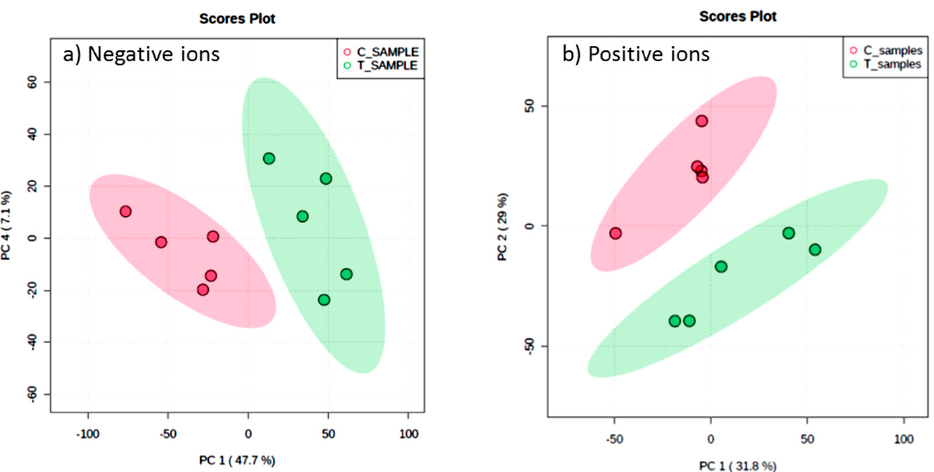
Figure 9. Scores plot between the selected principal components (PCs) in both ion modes of extracted samples; negative ion mode ( a ) and positive ion mode ( b ) groups, the control (C) and treatment (T) groups.